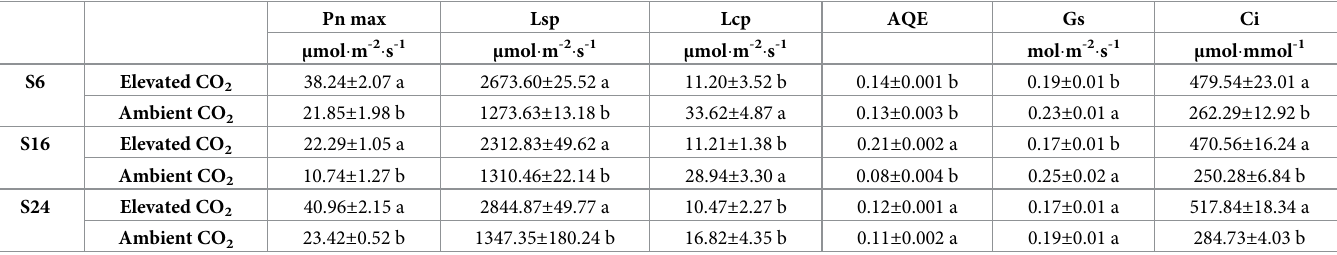
Table 2. Effect of elevated CO 2 on photosynthesis in